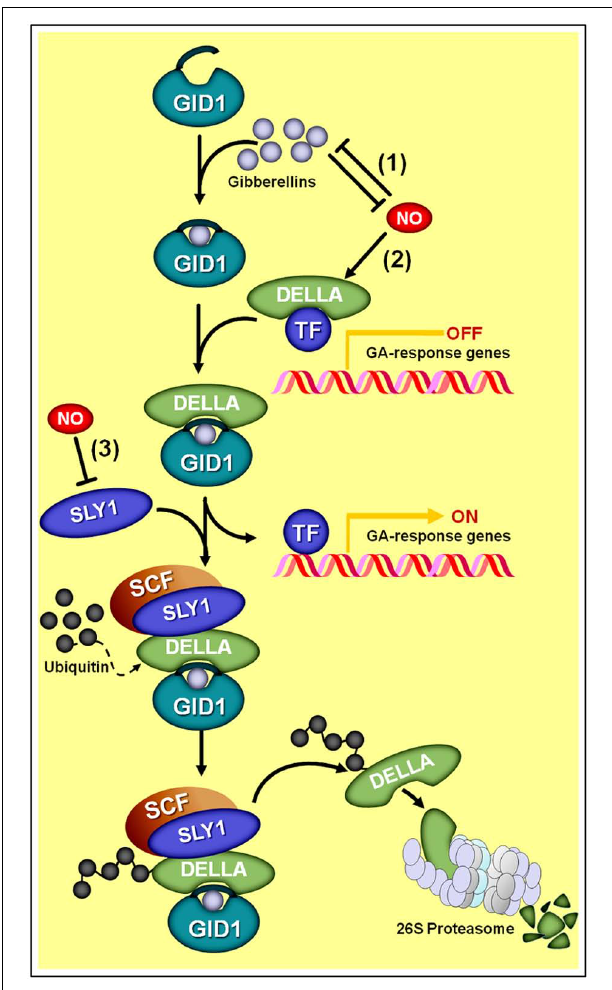
FIGURE 7 | Schematic representation of NO–gibberellin antagonistic interactions. (1) A mutual antagonism controls the endogenous levels of NO and gibberellins in Arabidopsis seedlings. (2) Additionally, NO negatively influences GA signaling by promoting the accumulation of DELLA proteins, whose presence represses the transcription of GA-regulated genes. Since the degradation of DELLAs through SCF-26S proteasome-mediated proteolysis depends on the interaction of these proteins with the complex formed by active gibberellin molecules associated with the receptor GA INSENSITIVE DWARF1 (GID1) and the E3 ubiquitin ligase SLEEPY1 (SLY1), the NO-driven increase in DELLAs and reduction in SLY1 abundance (3) negatively impacts the transduction of the GA